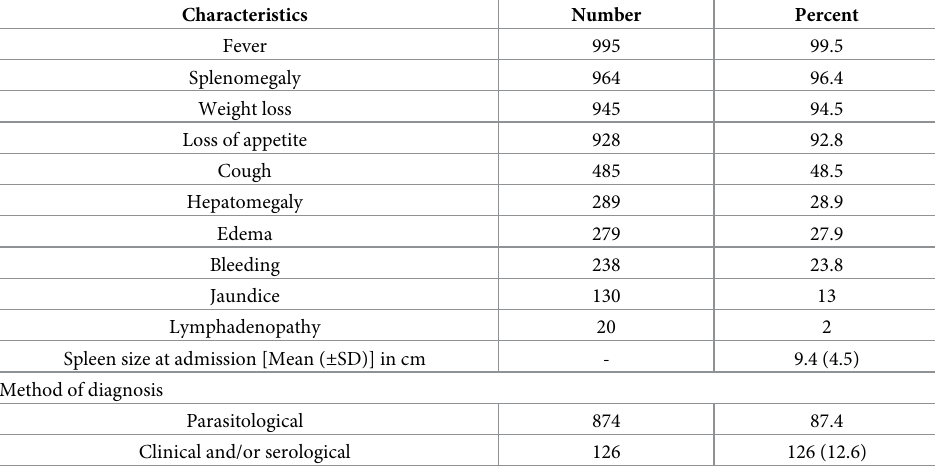
Table 1. Baseline Clinical Characteristics of VL patients Treated with SSG/PM at UoGH-LRTC from January 1, 2012 to June 30, 2019 Northwest Ethiopia (N =